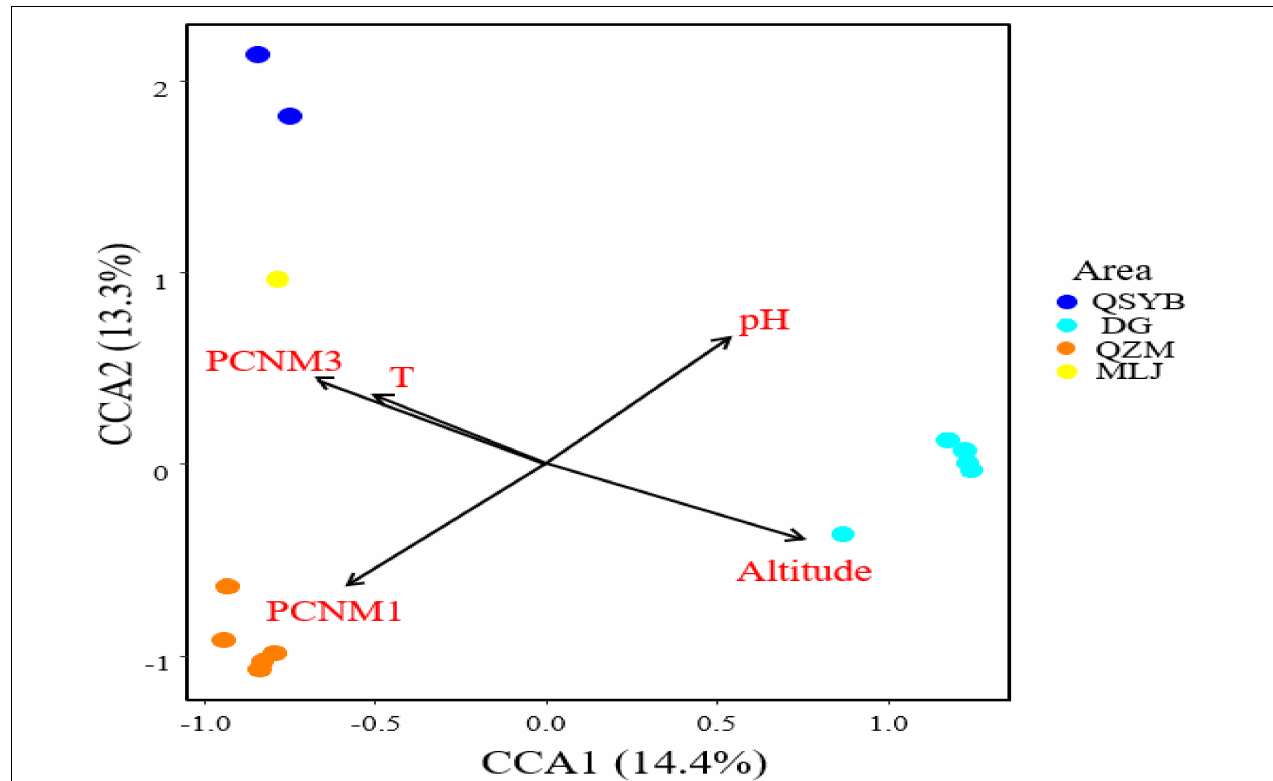
FIGURE 4 | CCA analysis showing the influence of environmental factors and geographic factors on the hydrogen-producing bacteria community structures. Assemblages sampled from the QZM, DG, DG01 (DG02-2), QSYB, and MLJ area are denoted in orange, sky blue, green, dark blue, and yellow,